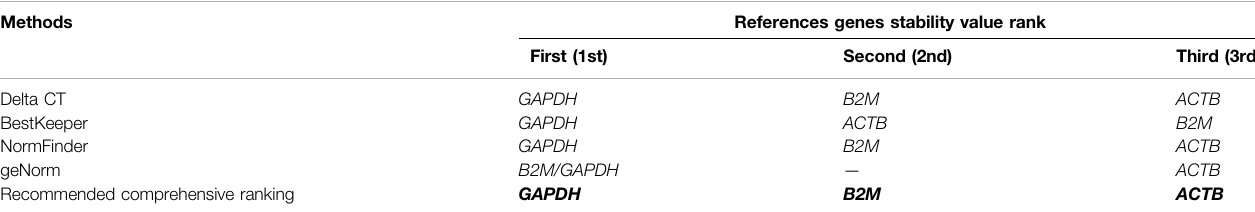
TABLE 4 | Ranking of the three reference genes stability.